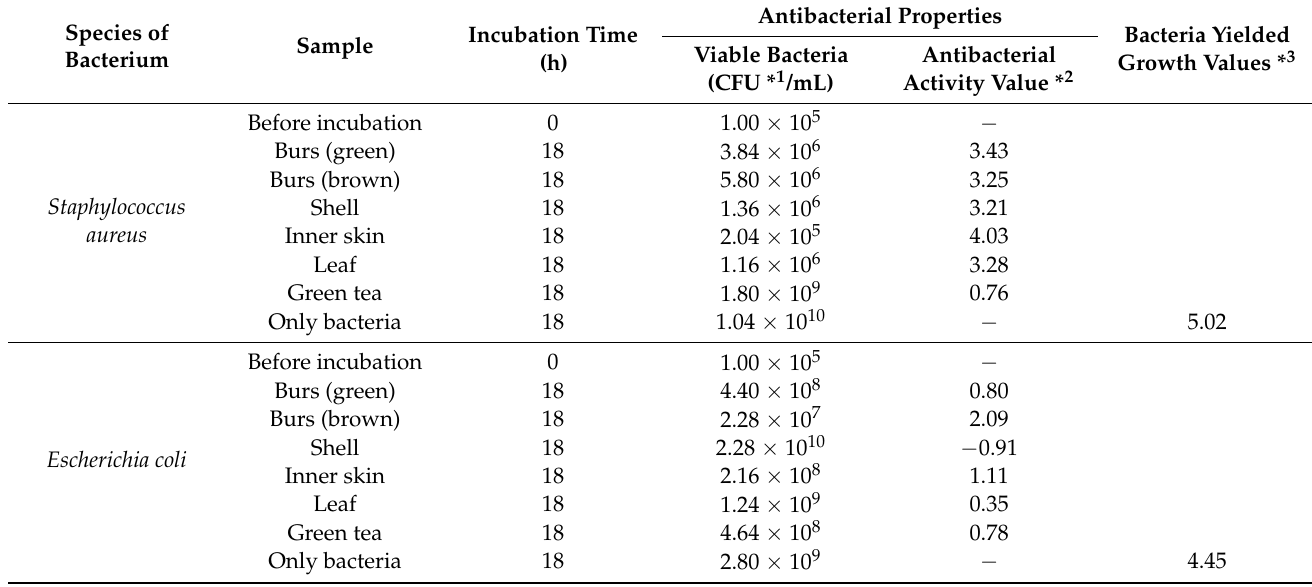
* 1 : Colony-forming units. * 2 : Antibacterial activity value = (logC t − logC 0 ) − (logT t − logT 0 ). logCt: log (Ave-age (count of viable cell after incubation of bacteria alone for a given period)); logC 0 : log (average (count of viable cell before incubation)); logT t: log (average (count of viable cell after incubation with chestnut samples for a given period)); logT 0: log (average (count of viable cell of the samples immediately after inoculation)). * 3 : Bacteria yield growth values = logC t − logC 0